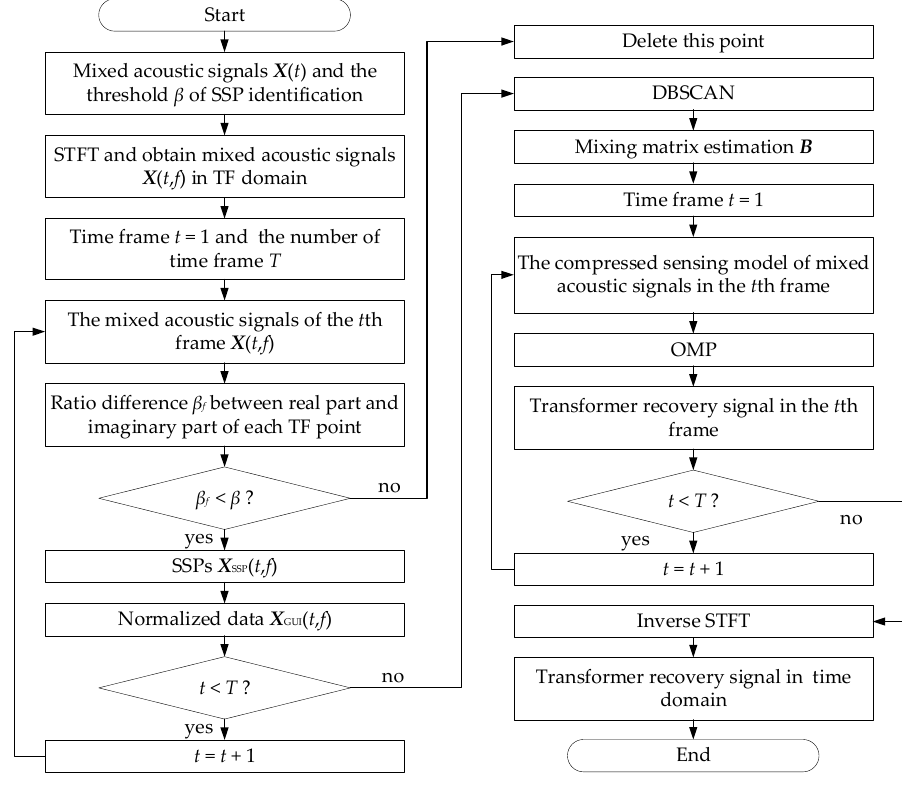
Figure 2. The Flowchart of the proposed